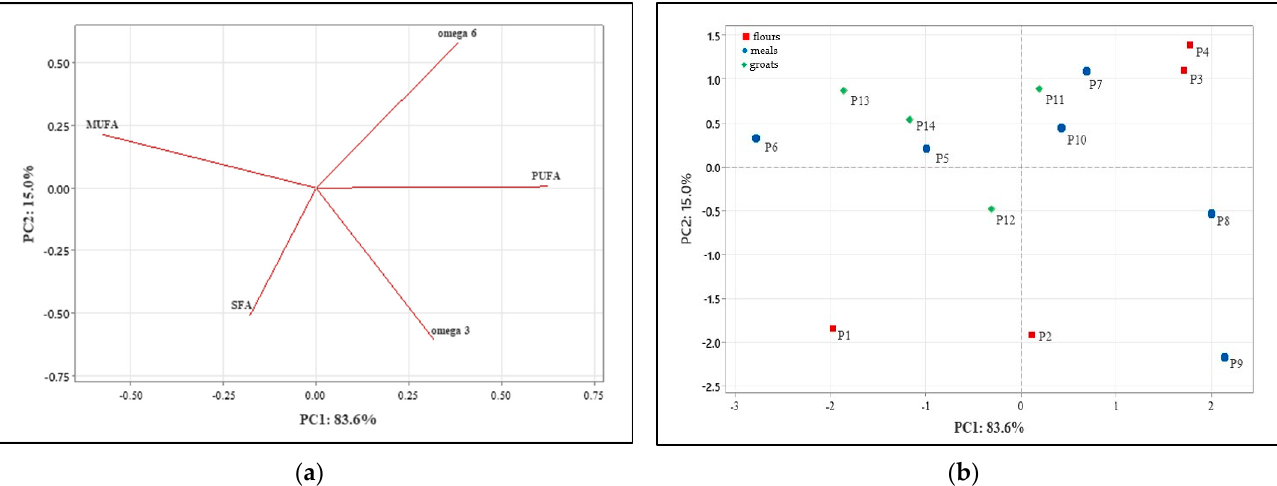
Figure 1. Principal component analysis: ( a ) score plot of first and second principal component (PC1 and PC2) describing the variability among the by-products analyzed; ( b ) loading plot of PC1 and PC2 describing the variation between the fatty acid composition of by-products.